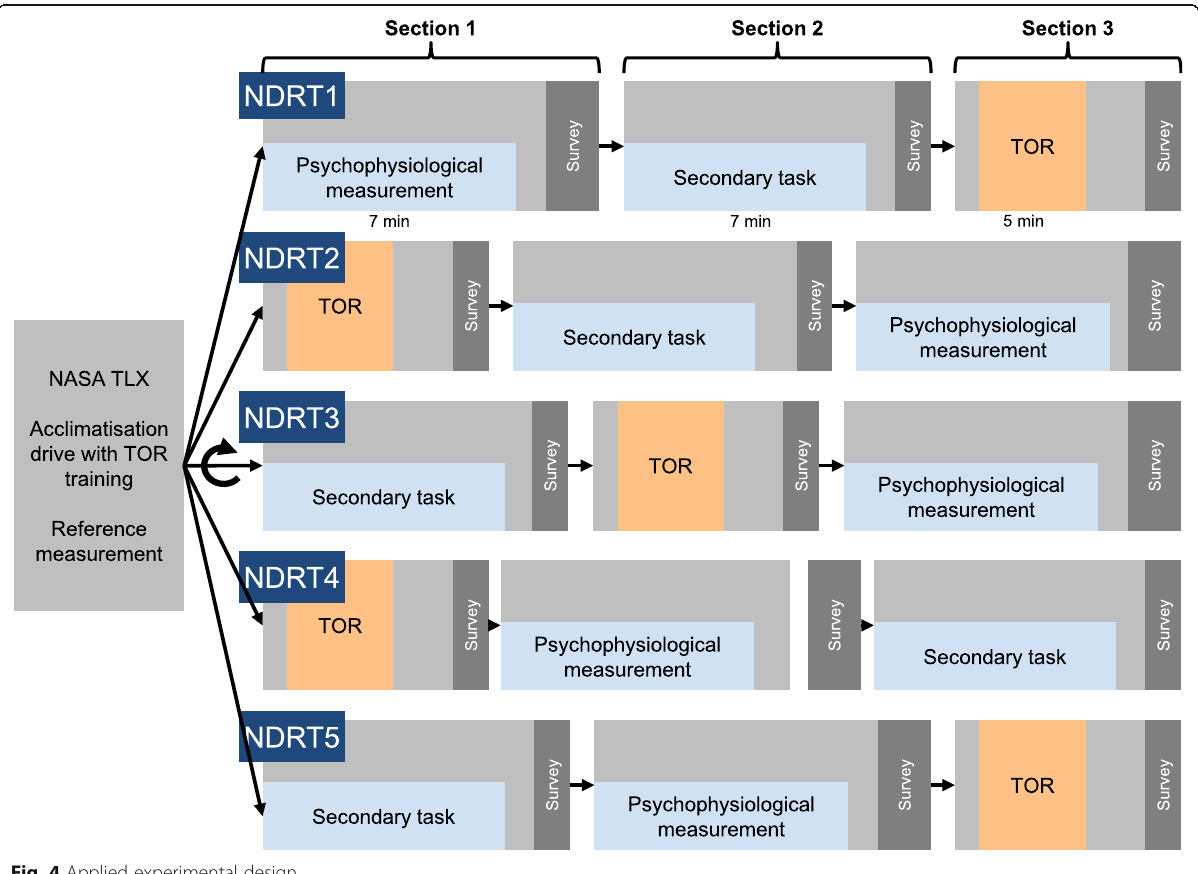
Fig. 4 Applied experimental